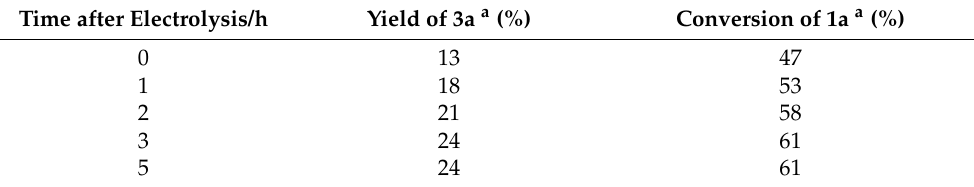
Table 4. Yield and conversion variation with time after stopping the electrolysis.